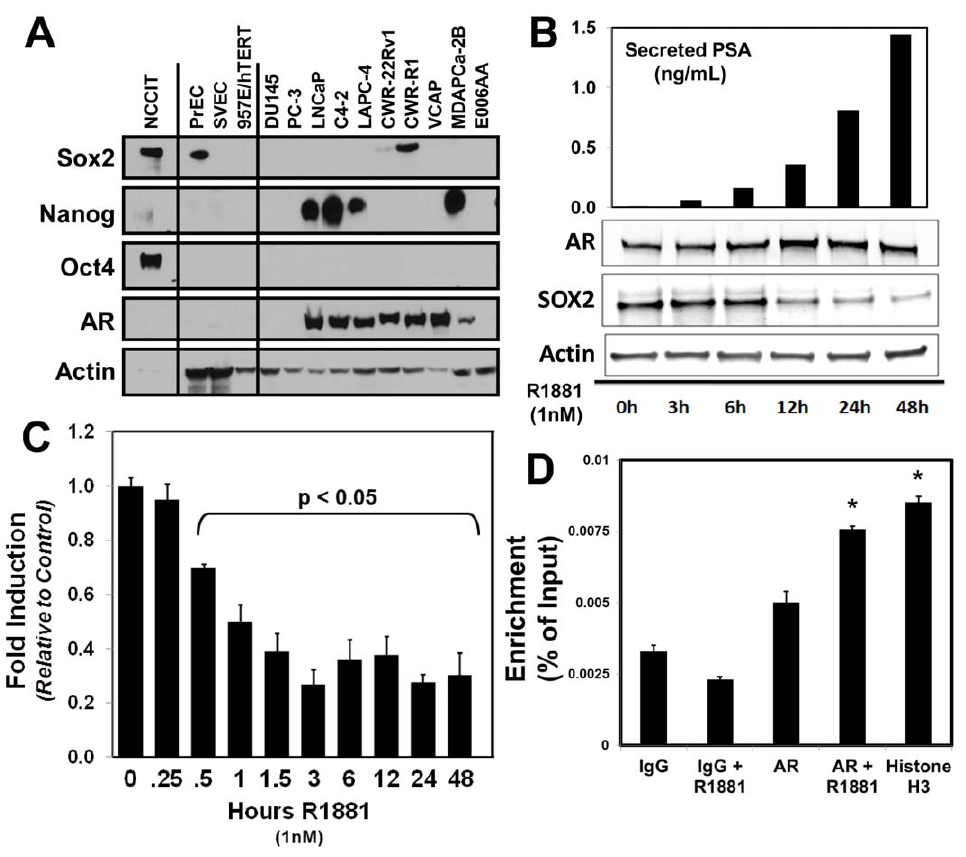
Figure 4. Androgen Receptor (AR) directly represses Sox2 expression in castration-resistant CWR-R1 cells. A ) Western blot of a panel of non-malignant and prostate cancer cell lines for Sox2, Nanog, Oct4, and AR. b -Actin was used as a loading control. Expression of Sox2 in castration- resistant CWR cells is not accompanied by co-expression of Nanog or Oct4. LNCaP, C4-2B, LAPC-4, and MDA-PCa2B cells expressed detectable Nanog, which is presumably the NanogP8 retrogene (Jeter et al., 2011). The human embryonal carcinoma cell line NCCIT was used as a positive control for Sox2, Nanog, and Oct4 at a 1:10 dilution. B ) Decreased expression of Sox2 upon AR stimulation with physiologic levels of androgen (1 nM R1881) in castration-resistant CWR-R1 prostate cancer cells. Protein lysates from cells treated at defined intervals (3–48 hours) after androgen treatment were subjected to western blotting, and accumulation of secreted PSA expressed in the media validates increased AR signaling. C ) Rapid decrease of Sox2 mRNA in CWR-R1 cells upon AR stimulation as measured by qPCR. Levels at 0.5 hrs and beyond represent a statistically significant decrease in Sox2 mRNA (p , 0.05). D ) AR Chromatin Immunoprecipitation (ChIP) documents direct binding of ligand-activated AR to the Sox2 enhancer region in response to AR stimulation by R1881. CWR-R1 cells were treated with vehicle control or 1 nM R1881, and enrichment of the Sox2 promoter after AR- ChIP was normalized as a percentage of total chromatin input. IgG and Histone H3 served as negative and positive controls, respectively. When compared to total input, both the positive control Histone H3 and ligand-activated AR significantly enriched for the Sox2 enhancer (p , 0.05). Data represents three independent experiments.